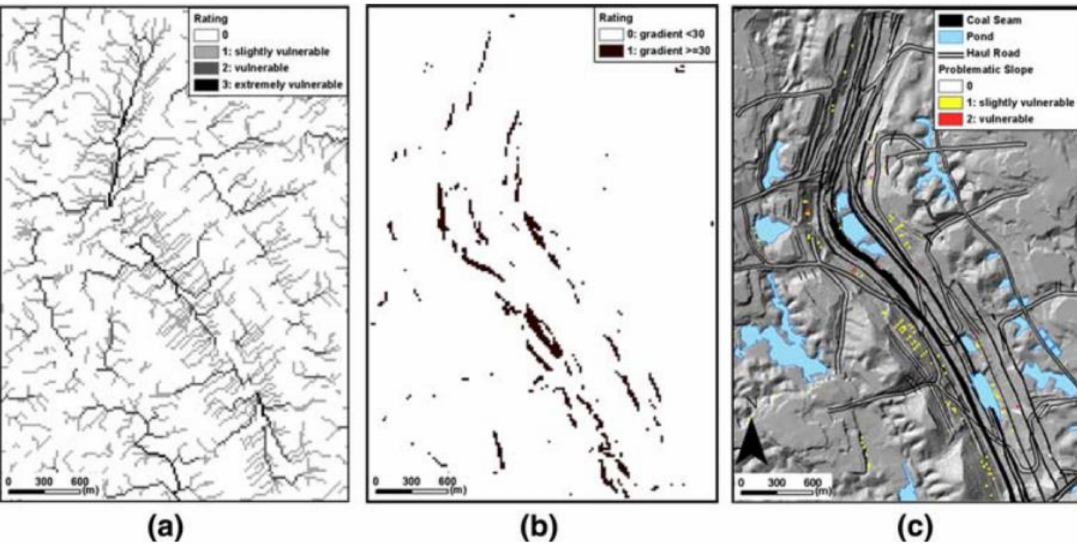
Figure 13. Rated value maps. ( a ) Rating the vulnerability to erosion from the flow accumulation of surface drainage. ( b ) Rating the slope gradient to extract steep bench slopes (30 ◦ C). ( c ) Locations of bench slopes vulnerable to gully erosion during rainfall